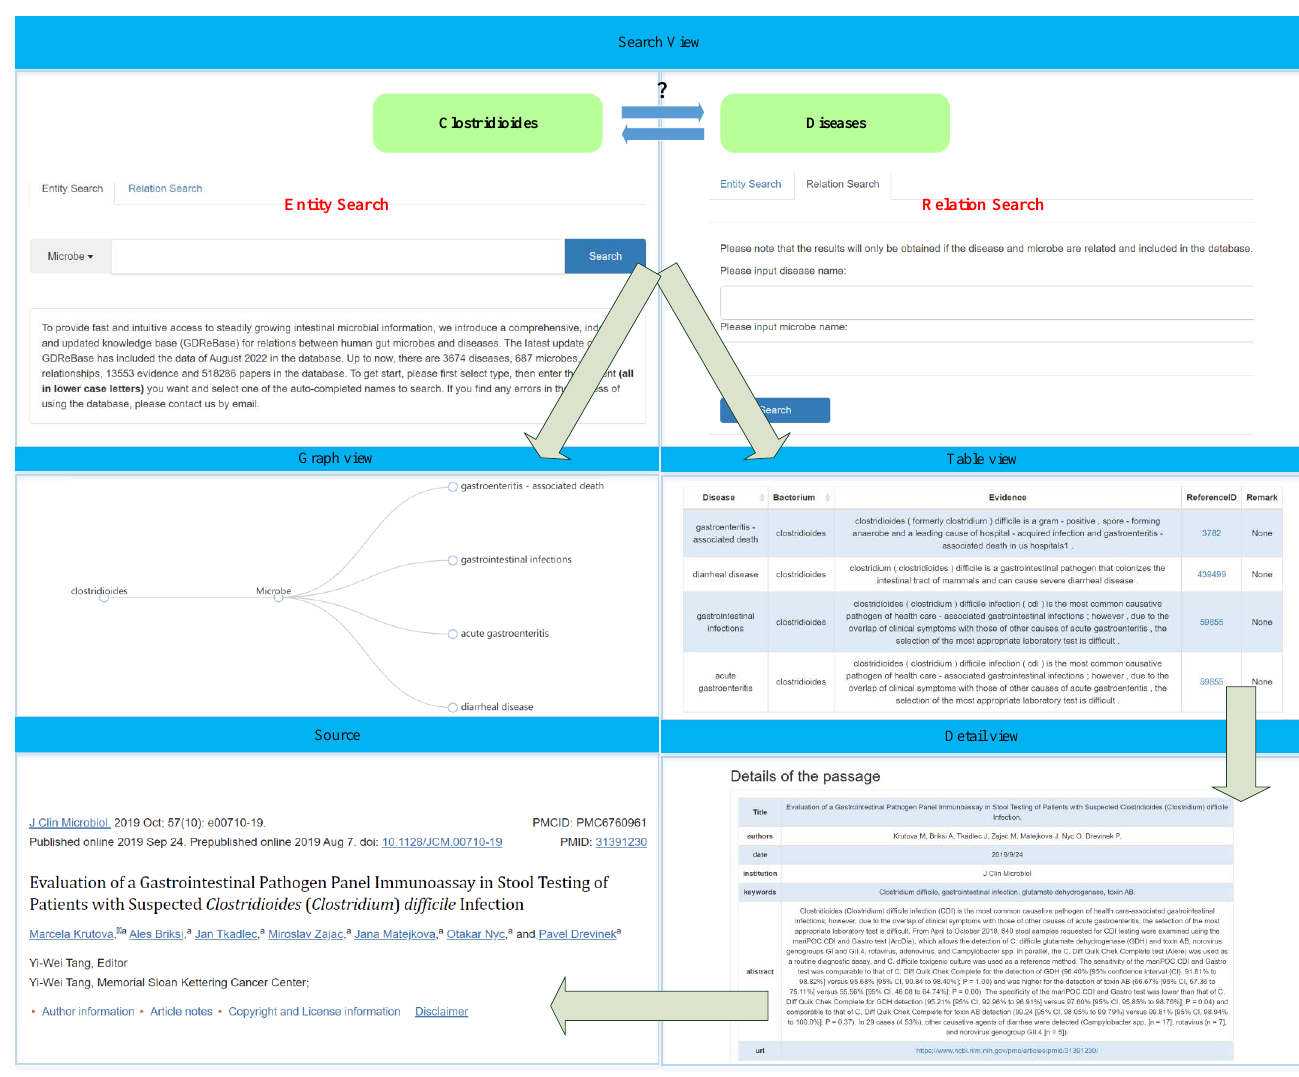
Figure 3. Different views of web pages and GDReBase